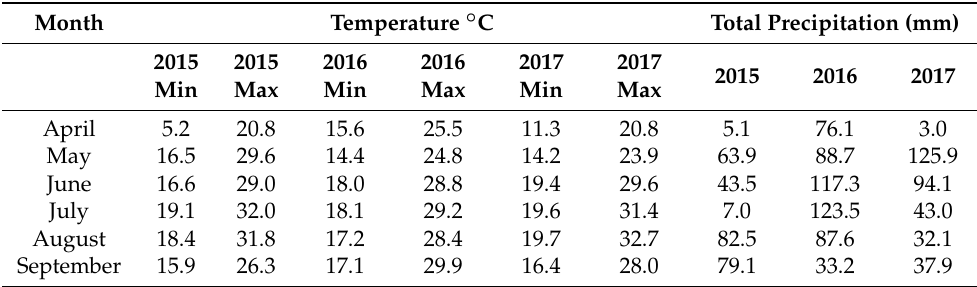
Table 2. Average air temperature and total precipitation during 2015 to 2017 growing seasons (April to September) in South Banat district,